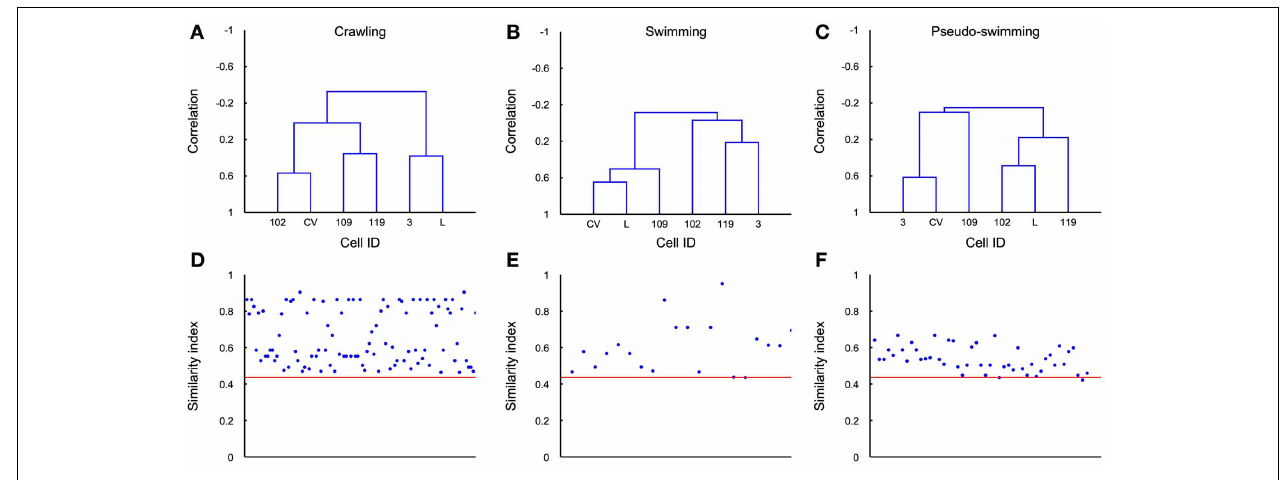
FIGURE 9 | Average dendrograms. (A–C) The average dendrogram for crawling, swimming and pseudo-swimming, respectively, was estimated using all the recorded episodes in 5 experiments (for each of the behaviors) and using the average firing rates of the 6 most reliably identified cells. (D–F)